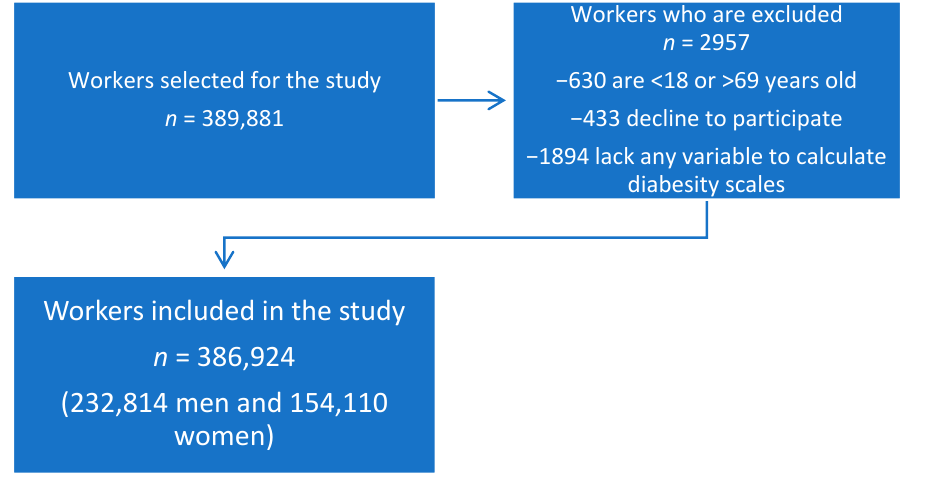
Figure 1. Flowchart of the study participants.